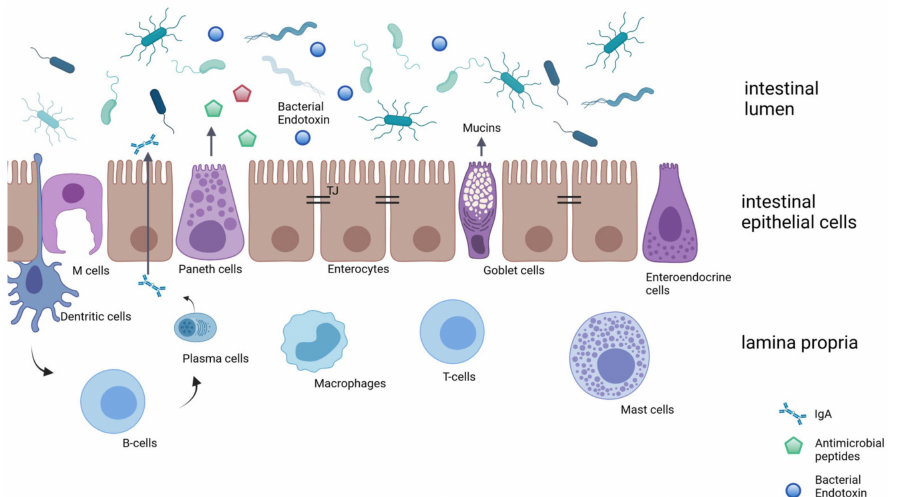
Figure 2. Schematic drawing of the intestinal barrier. The intestinal barrier includes a microbial, biochemical, physical, and immunological barrier. While the biochemical barrier consists of mucins and antimicrobial peptides, the physical barrier is composed of the epithelial monolayer with, e.g., enterocytes, goblet cells, enteroendocrine cells, Paneth cells, and microfold cells (M cells). Within the lamina propria, different immunological cells interact with the intestinal barrier, e.g., macrophages, dendritic cells, T cells, or mast cells. IgA: Immunoglobulin A. Modified after [3,11,12] and created with BioRender.com (accessed on 16 February